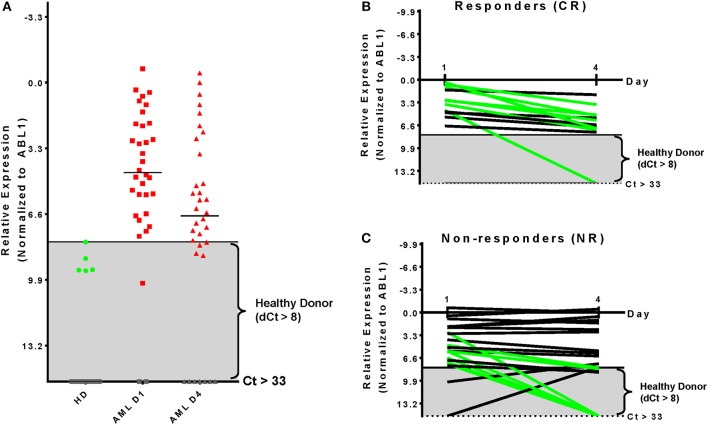
Kinetics of WT1 expression during chemotherapy is uninformative for clinical response. (A) Thresholds for WT1 overexpression in blood for this assay were established based on the upper limit observed by qPCR in 34 healthy donors and were consistent with previous reports (24). AML patient blood samples showed overexpressed WT1 levels in 31 (91%) on Day 1 and 23 (68%) at Day 4. (B) Patients achieving a complete remission after therapy had at least a 4-fold reduction of WT1 expression during therapy in 7 of 13 cases evaluated by qPCR (54%); 5/13 (38%) had <4-fold reduction; 1/13 (8%) had undetectable WT1 levels. (C) Non-responding patients had at least a 4-fold reduction of WT1 expression in 7 of 21 evaluated by qPCR (33%) NR; 14/21 (67%) had less than a 4-fold change. Two patients initially had WT1 levels that were not overexpressed, but became so by treatment day 4. qPCR, quantitative real-time PCR; Green, at least 4-fold decrease; Black, <4-fold change; Gray, undetectable; Gray box indicates healthy donor range.